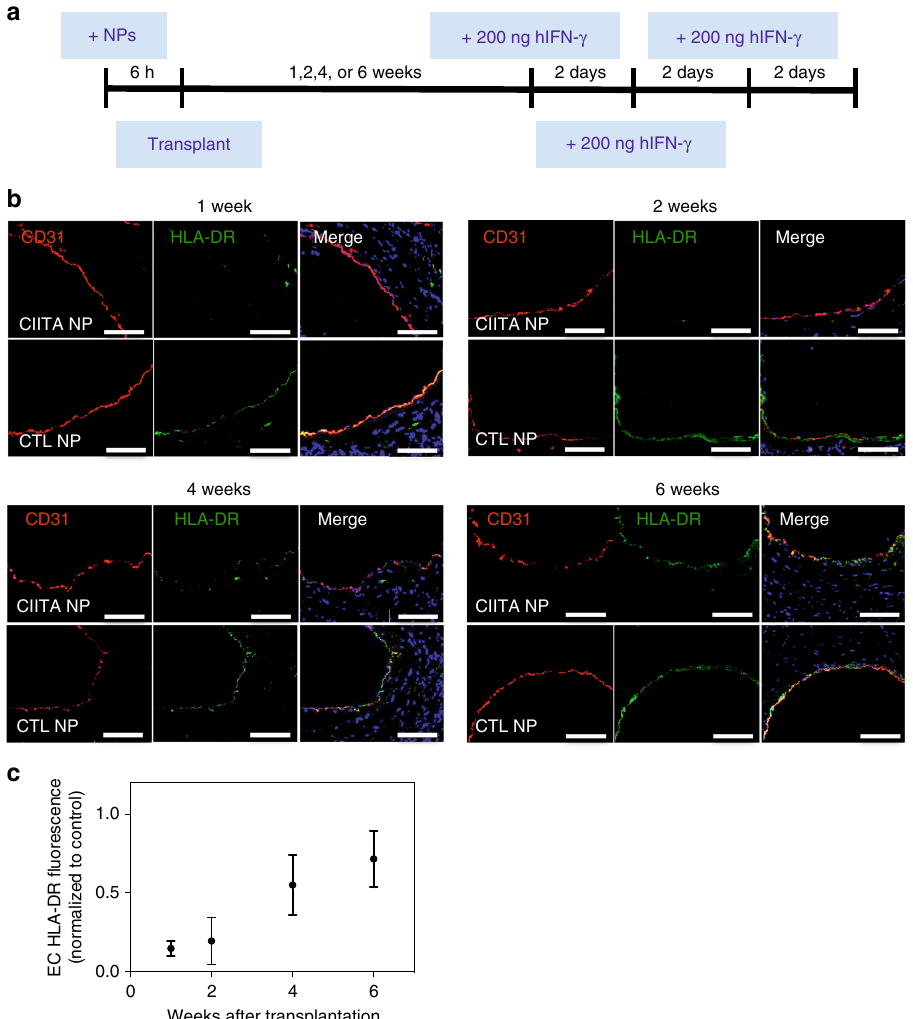
Fig. 6 NPs suppress MHC class II expression for up to 6 weeks in transplanted human arteries in vivo. a Human arterial allografts pretreated with siRNA-NPs show reduction of HLA-DR on ECs for up to 6 weeks in vivo. Coronary arteries were incubated with siRNA-loaded NPs for 6 h and transplanted into SCID/beige mice. Three doses of hIFN- γ were administered every other day for 1 week. b After 1, 2, 4, or 6 weeks, arteries were harvested, sectioned, and stained using anti-CD3 antibody ( red ), anti HLA-DR antibody ( green ), and DAPI ( blue ), scale bar : 100 μ m. c HLA-DR fl uorescence was quanti fi ed from the images using ImageJ and normalized to CTL NP treated arteries. Data shown is mean ± SD ( n =